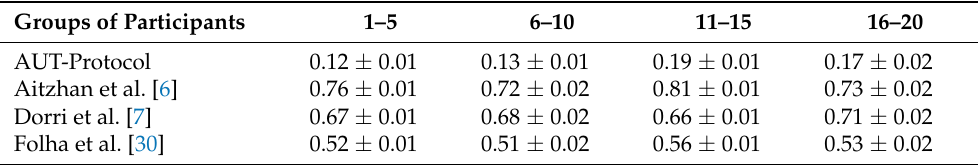
’s success per group of participants in the system. Table 3. Results for A Groups of